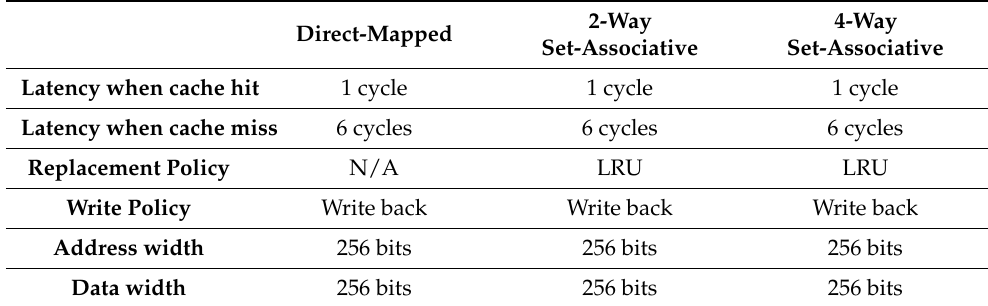
Table 3. Characteristics of cache systems.